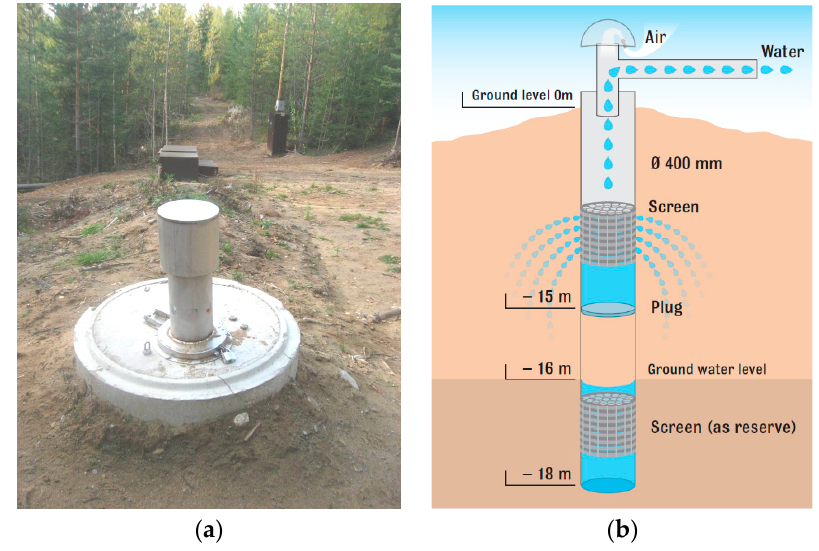
Figure 5. ( a ) An Infiltration well at Vehoniemi MAR site, with the wellhead in the forefront and influent flow metering box in the background (Photographer, M. Mäkinen); ( b ) The principle of well infiltration at Rusutjärvi MAR plant: infiltrated water is led to the unsaturated zone with an option to lead it directly to the saturated zone.